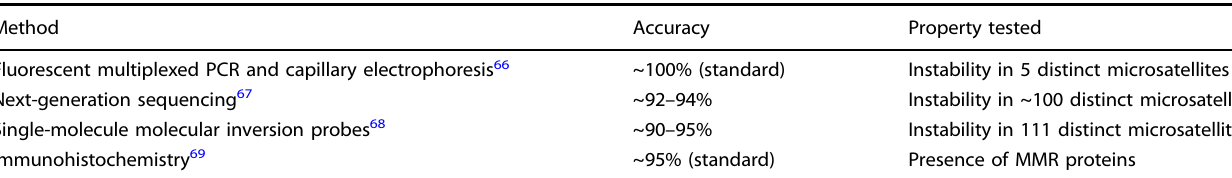
Table 1. MSI detection